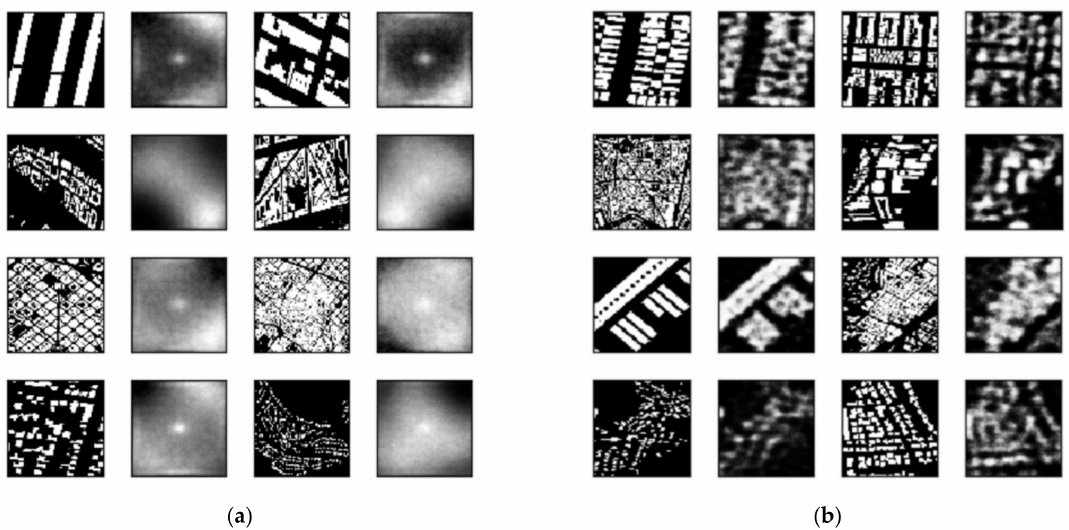
Figure 9. City images and their corresponding reconstructions. ( a , b ) An alternation of columns from the left-hand side to the right-hand side show original and reconstructed images. Each row is selected randomly from a pattern class, and they are from top to bottom New York City, Paris, Barcelona, and Germany, respectively. The figure images are reconstructed using Autoencoder_6 with six neurons at the bottleneck section, whereas figure b shows images that are reconstructed using Autoencoder_200 with 200 neurons in the bottleneck section.